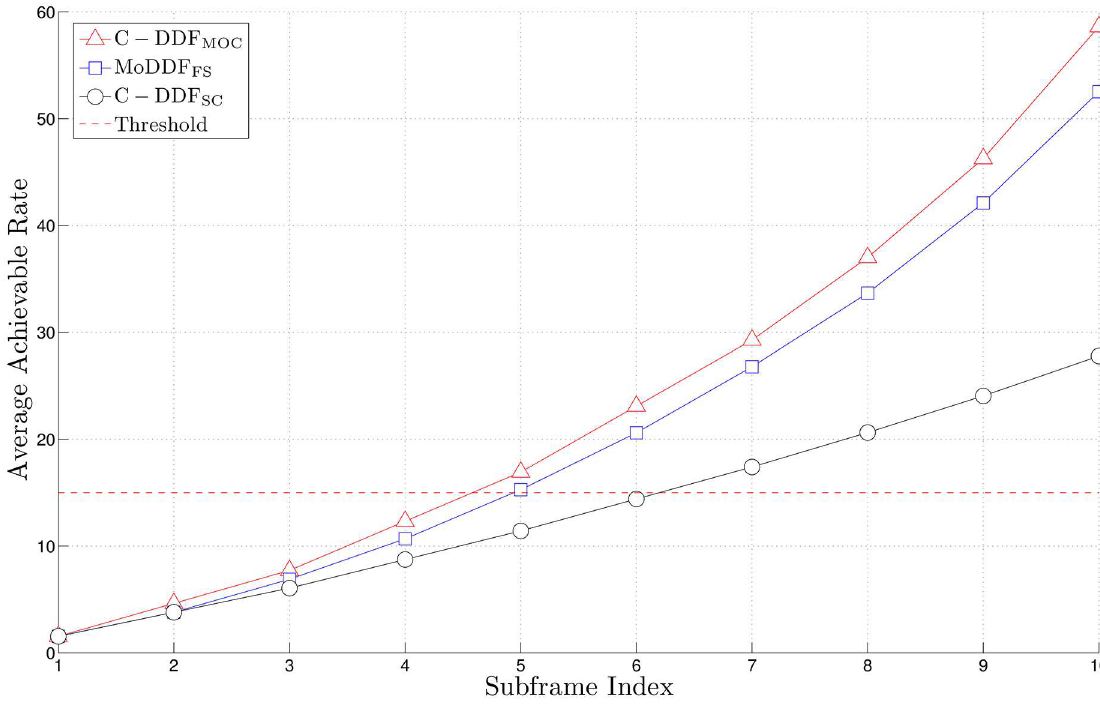
Fig 8. Average achievable rate over a frame with M = 7, N = 10, and g ¼ 7 : 4 dB.